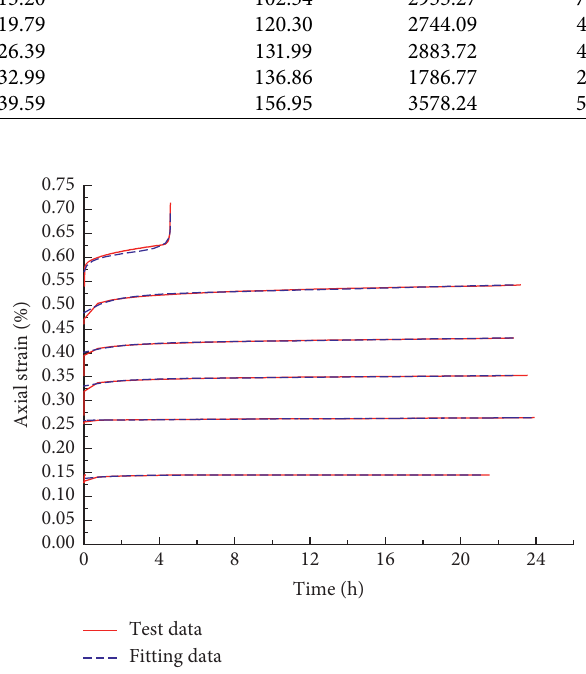
Figure 13: Comparison between the fitting curve and the test curve of the improved Nishihara model under the confining pressure of 7MPa.